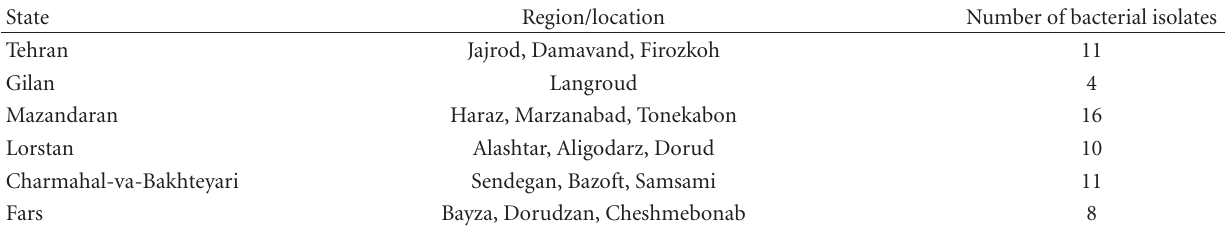
Table 1: Regional locations of the a ff ected trout farms used for isolation of S. inaie .